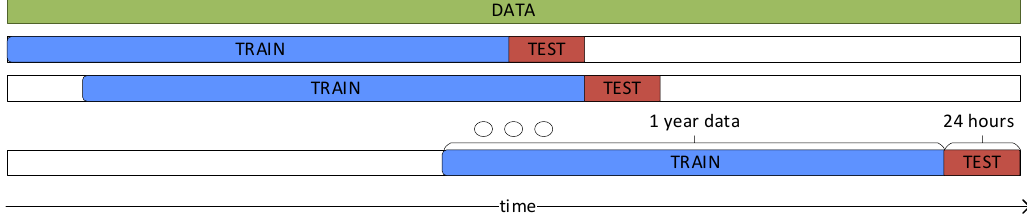
Figure 8. Employed walk forward validation